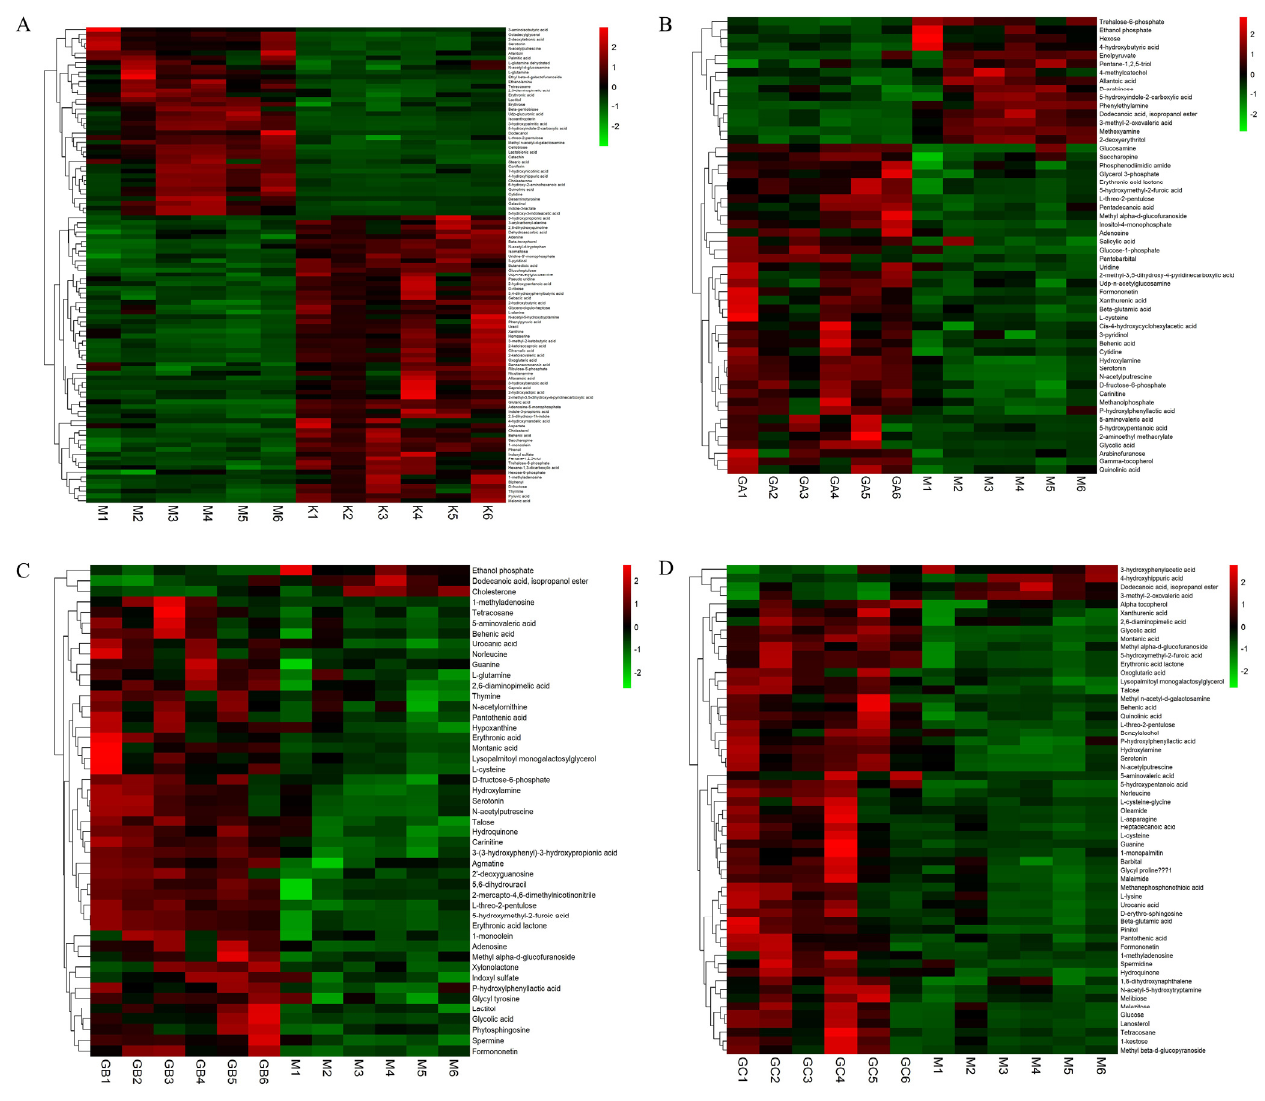
Figure 2. Hierarchical clustering of significantly different metabolite expression results: ( A ) clustering heatmap of samples between group K and group M; ( B ) clustering heatmap of samples between group GA and group M; ( C ) clustering heatmap of samples between group GB and group M; ( D ) clustering heatmap of samples between group GC and group M. ( A – D ) The colors from green to red indicates that the expression abundance levels of metabolites range from low to high. The redder the color, the higher the expression abundance of different